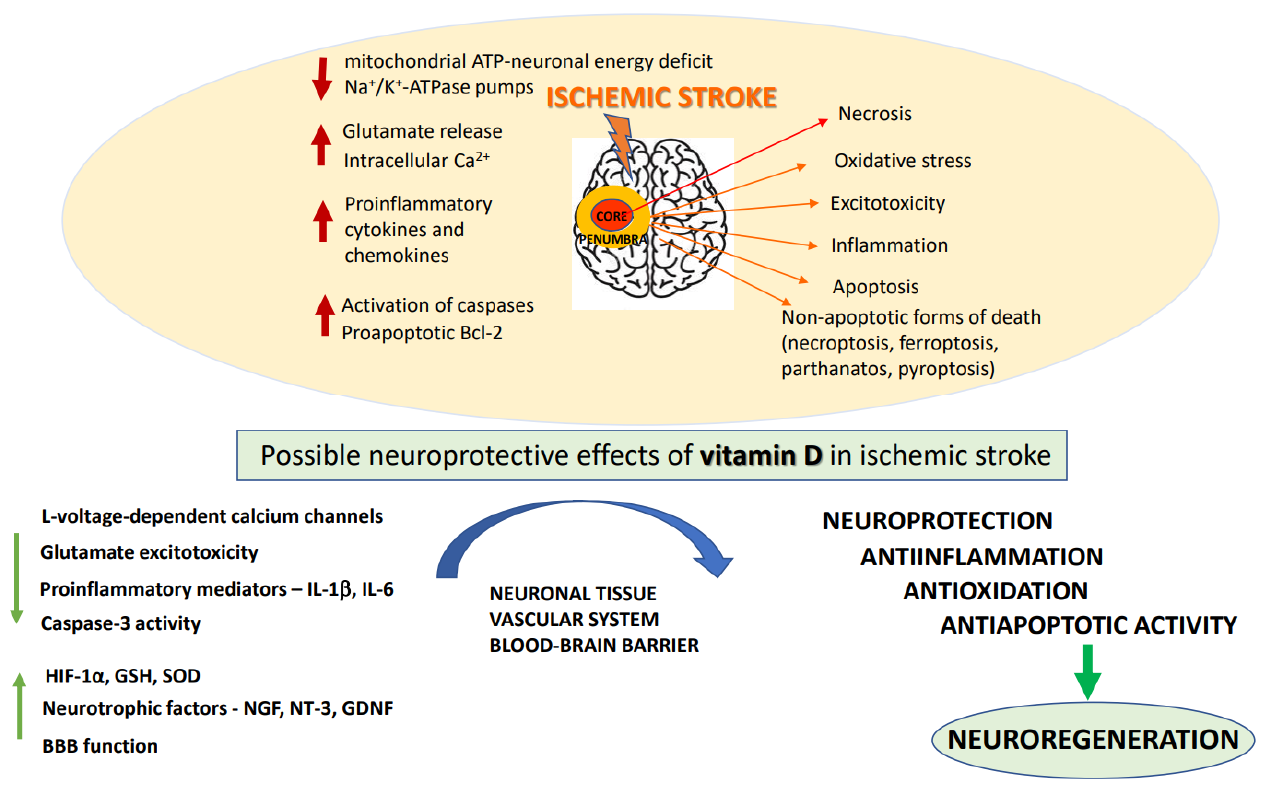
Figure 1. The pathogenic mechanisms of ischemic stroke and neuroprotective effects of vitamin D. BBB: blood–brain–barrier; GDNF: glial-derived neurotrophic factor; GSH: glutathione; HIF: 1a-hypoxia-inducible factor; IL: interleukins; NGF: nerve growth factor; NT: 3-neutrophin-3; SOD: superoxide dismutase.